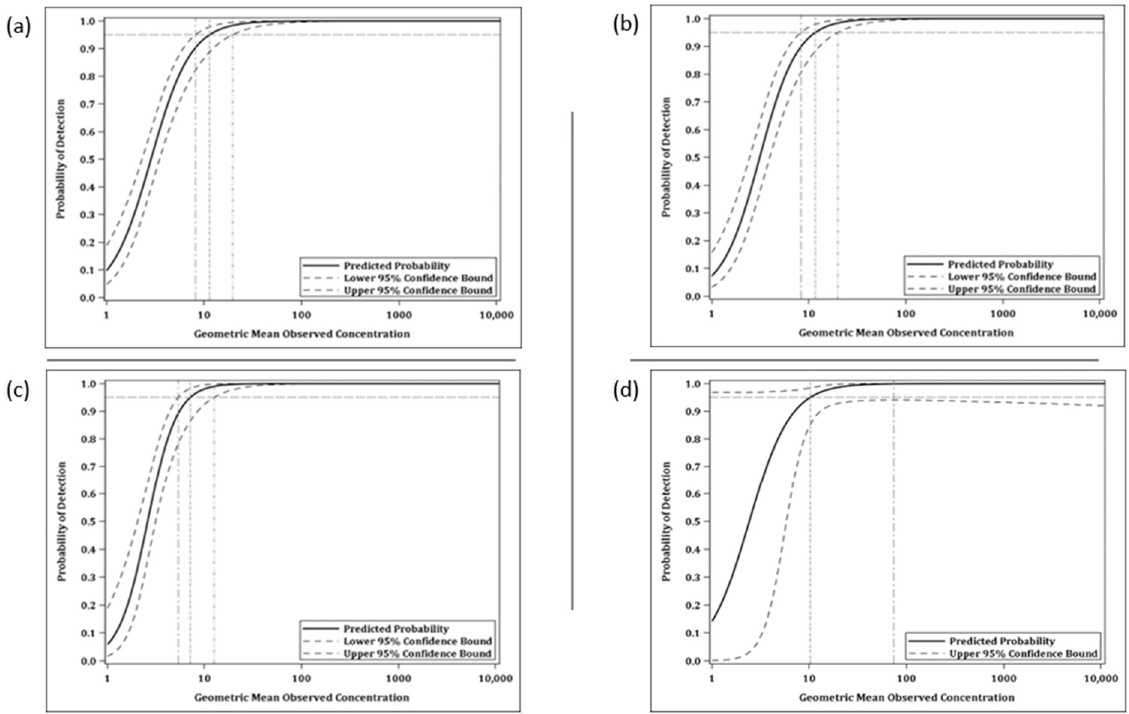
Figure 9. Logistic regression curve showing relationship between the probability of detecting the concentration and the mean log-transformed observed value. ( a ) MARV and human; ( b ) MARV and NHP; ( c ) SUDV and human; ( d ) SUDV and